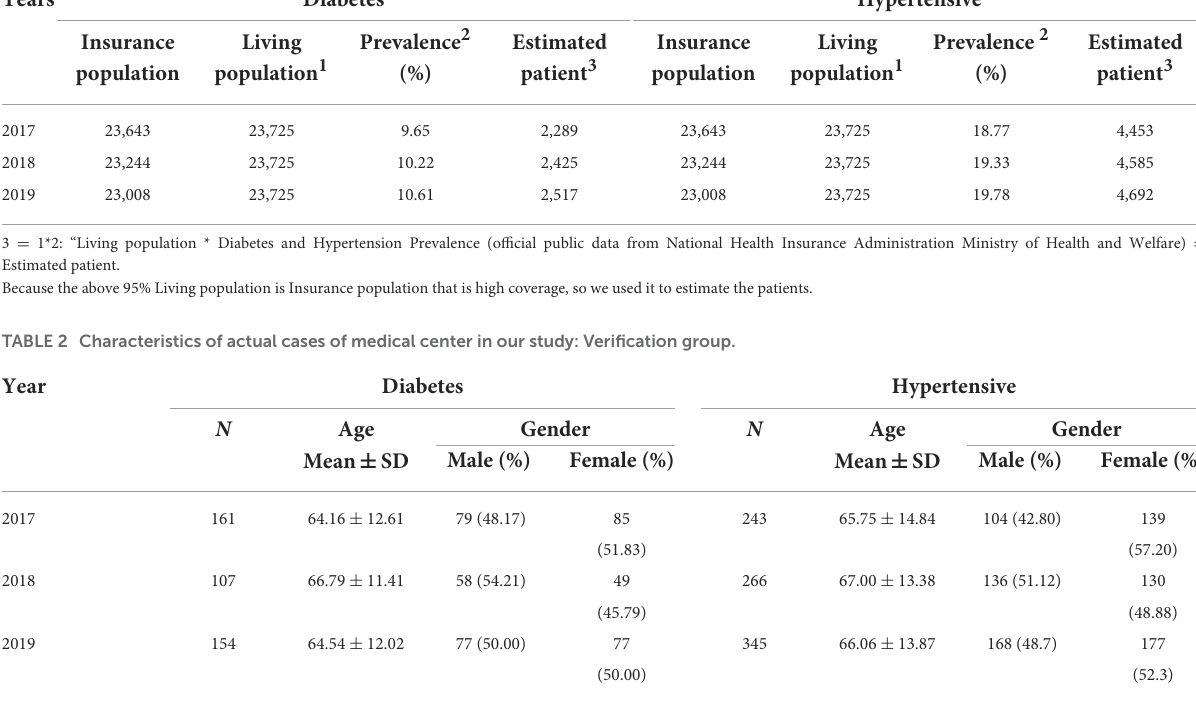
TABLE 1 The prevalence of diabetes and hypertensive from official public data in Yuli. Years Diabetes Hypertensive Insurance Living Estimated population